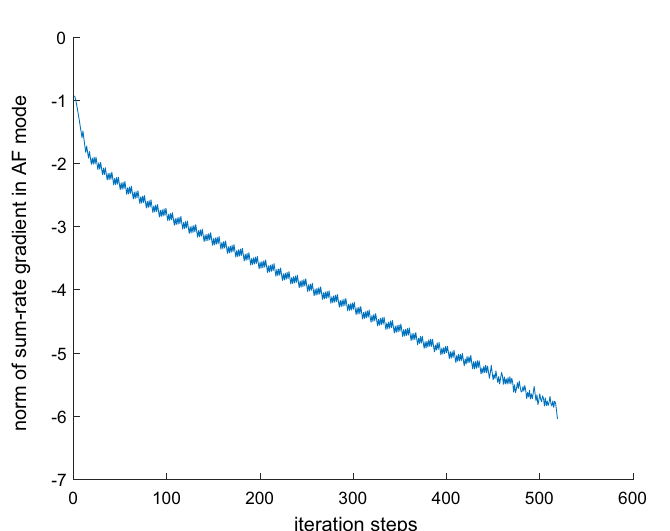
Fig. 6 Norm of sum-rate gradient in AF mode. It is the sum-rate norm curves curve when the relay nodes are 8 and the transmit SNR is 25 db in AF mode